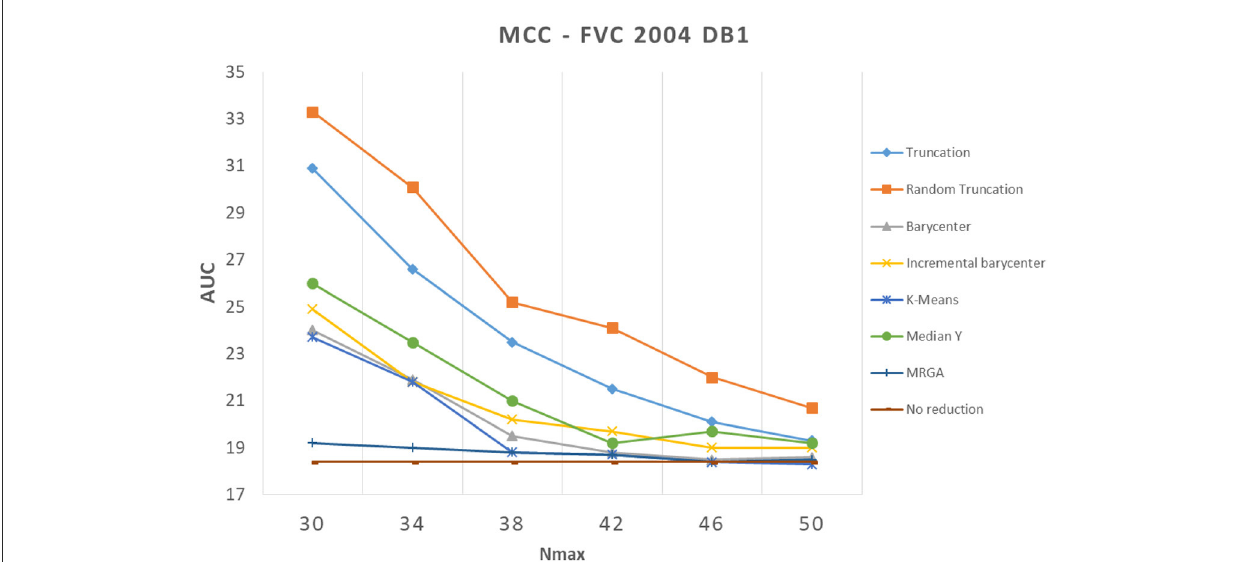
FIGURE7 Comparison of template reduction methods on the FVC 2004 DB1 with the MCC matching algorithm.